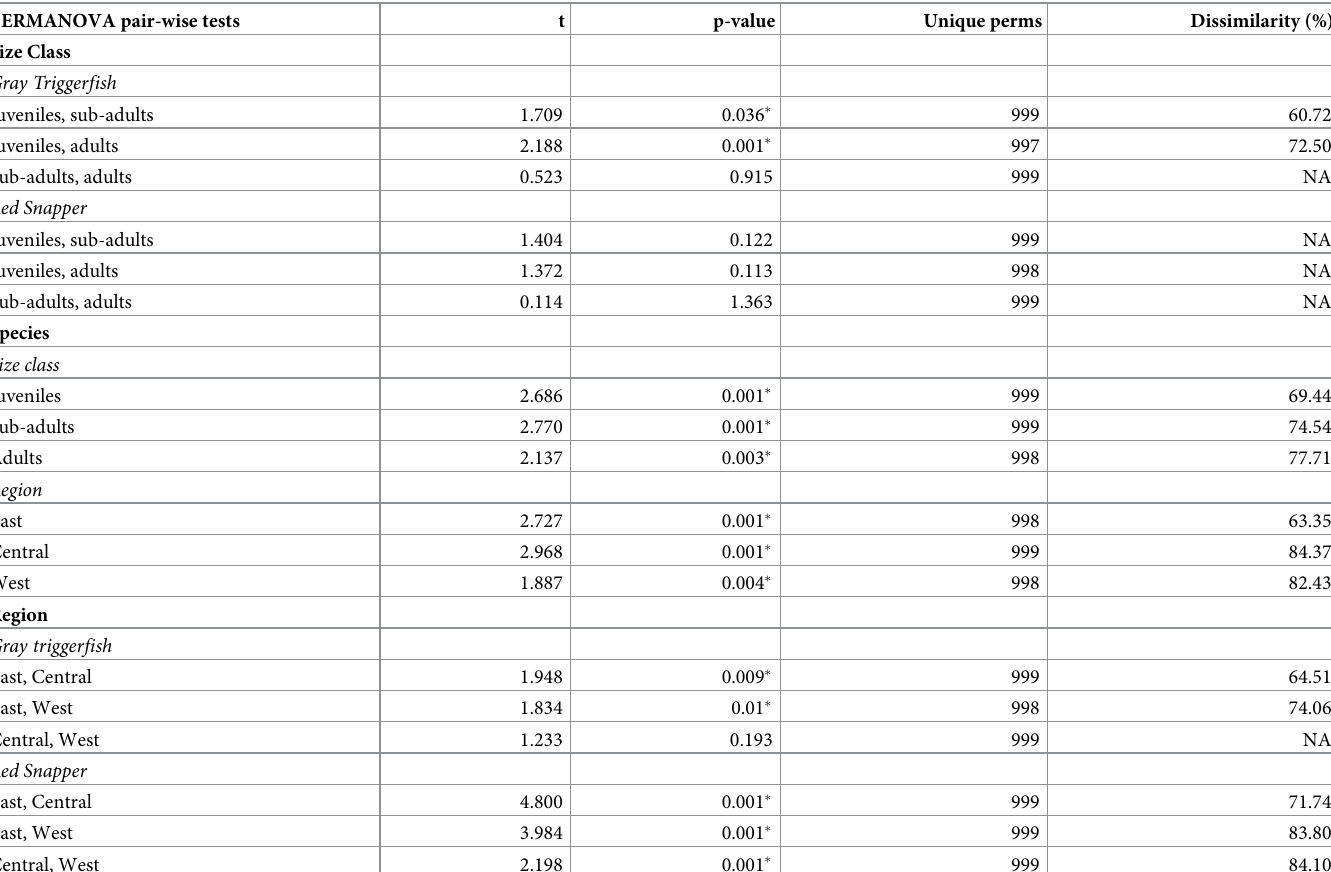
Table 2. Permutational analysis of variance (PERMANOVA) and similarity percentages (SIMPER) examining gut content composition. PERMANOVA pair-wise